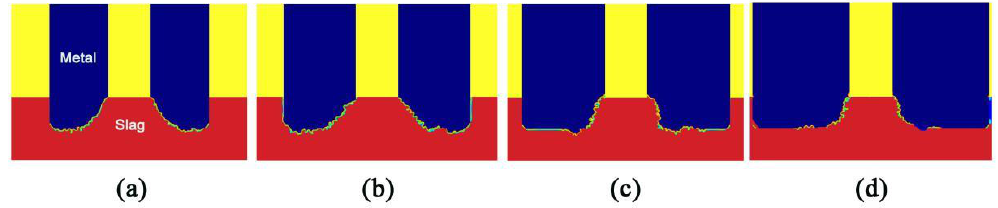
Figure 15. Shape of electrode tip with different filling rate in the numerical simulation. ( a ) 0.5; ( b ) 0.6; ( c ) 0.7; ( d ) 0.8.